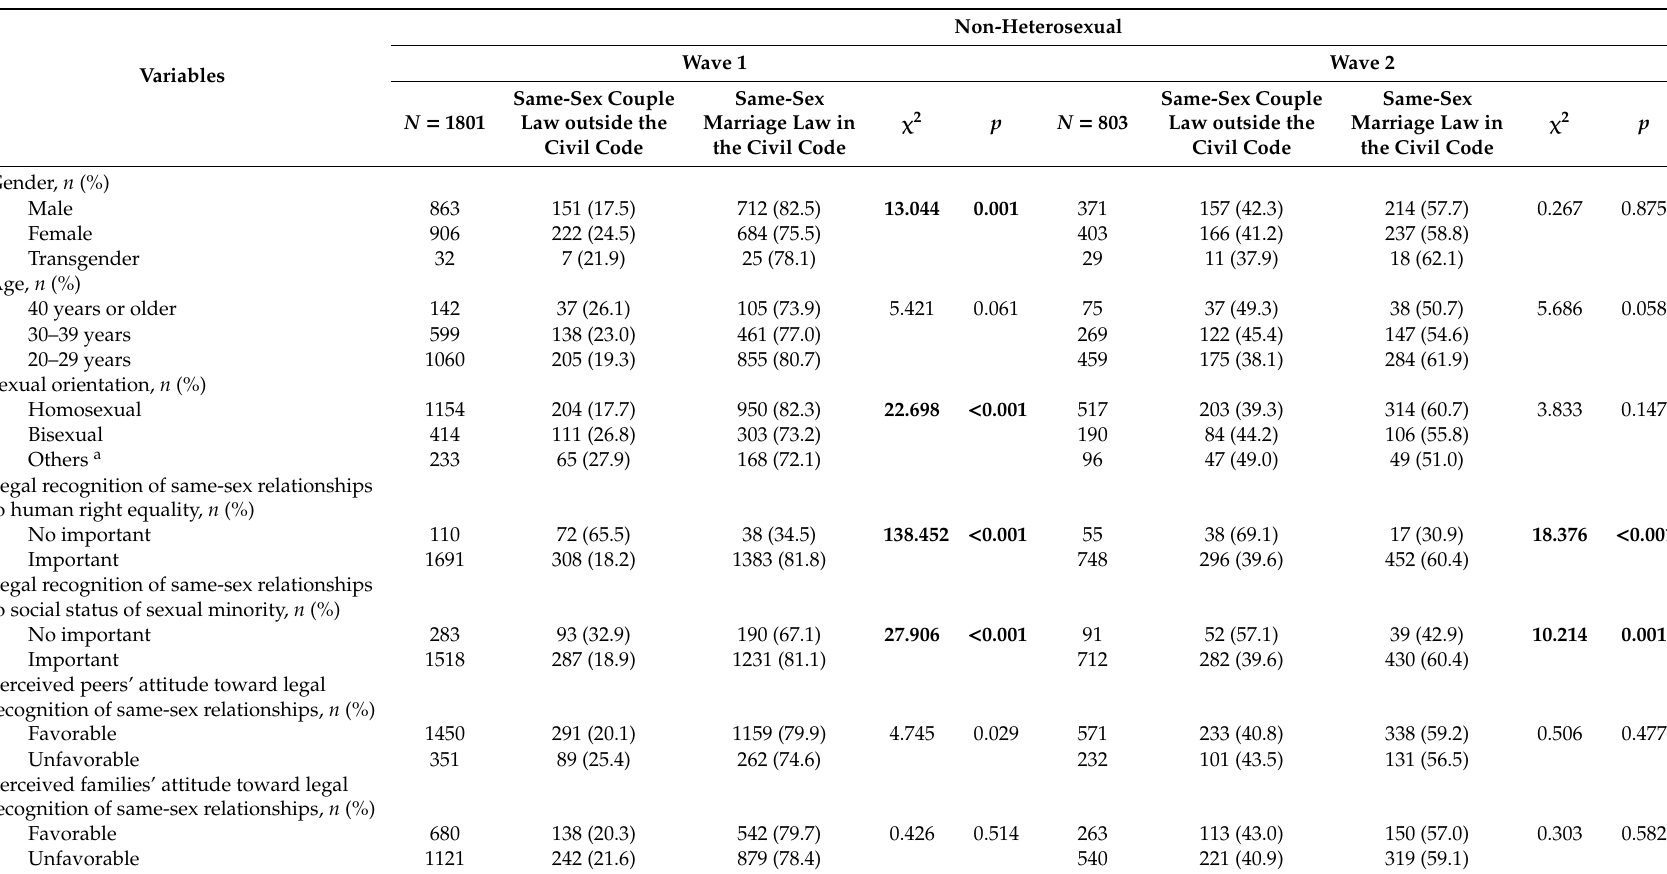
Table 5. Comparison of gender, age, sexual orientation, personal belief, and perceived social attitudes between non-heterosexual participants supporting the legalization of same-sex relationships with various preferences of forms of laws in Wave 1 and Wave